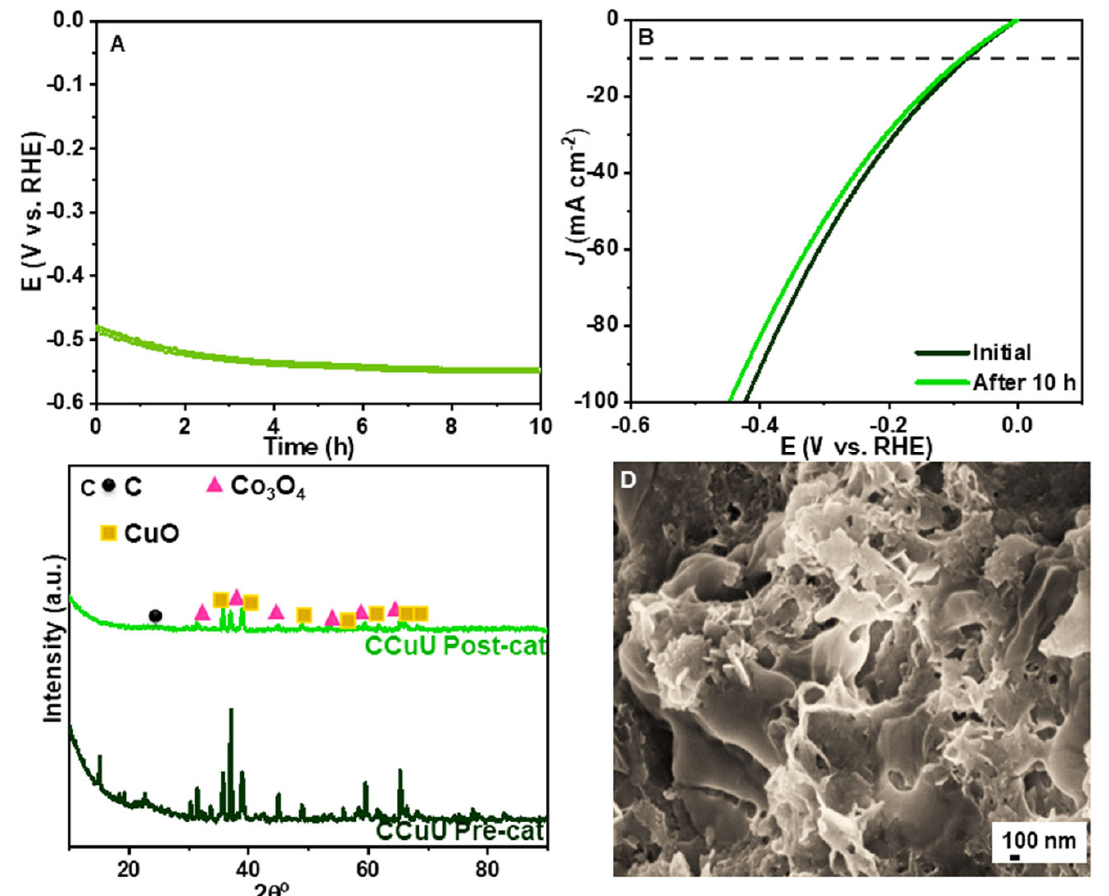
Figure 6. ( A ) Chronopotentiometry test of CCuU over 10 h ( B ) LSV curves before and after scanning. Post ‐ HER ( C ) XRD pattern and ( D ) FESEM image of CCuU. Post-HER ( C ) XRD pattern and ( D ) FESEM image of